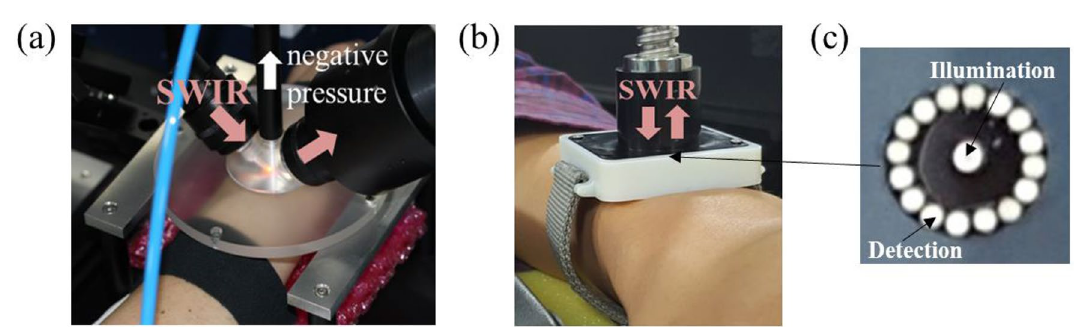
Figure 3. SWIR Skin measurement system with a transflection configuration ( a ) and a reflection configuration ( b ), enlarged bottom view of the reflection skin probe composed of 1 illumination and 16 detection optical fibers ( c